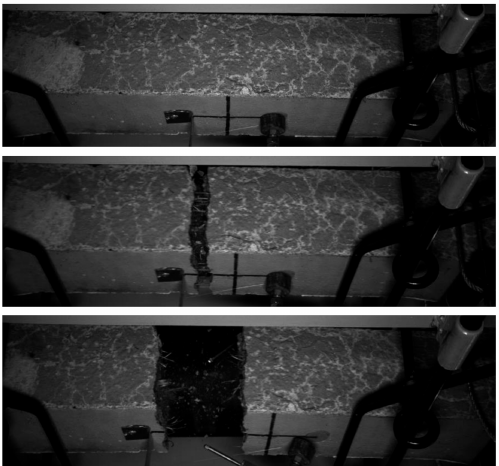
Figure 19. Cracking of PM_2 dog-bone specimen during the tensile